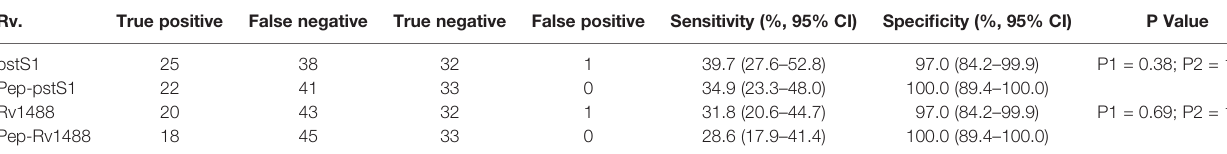
TABLE 4 | Comparison of the differences of sensitivities and speci fi cities between polypeptides and their corresponding antigens. Rv.